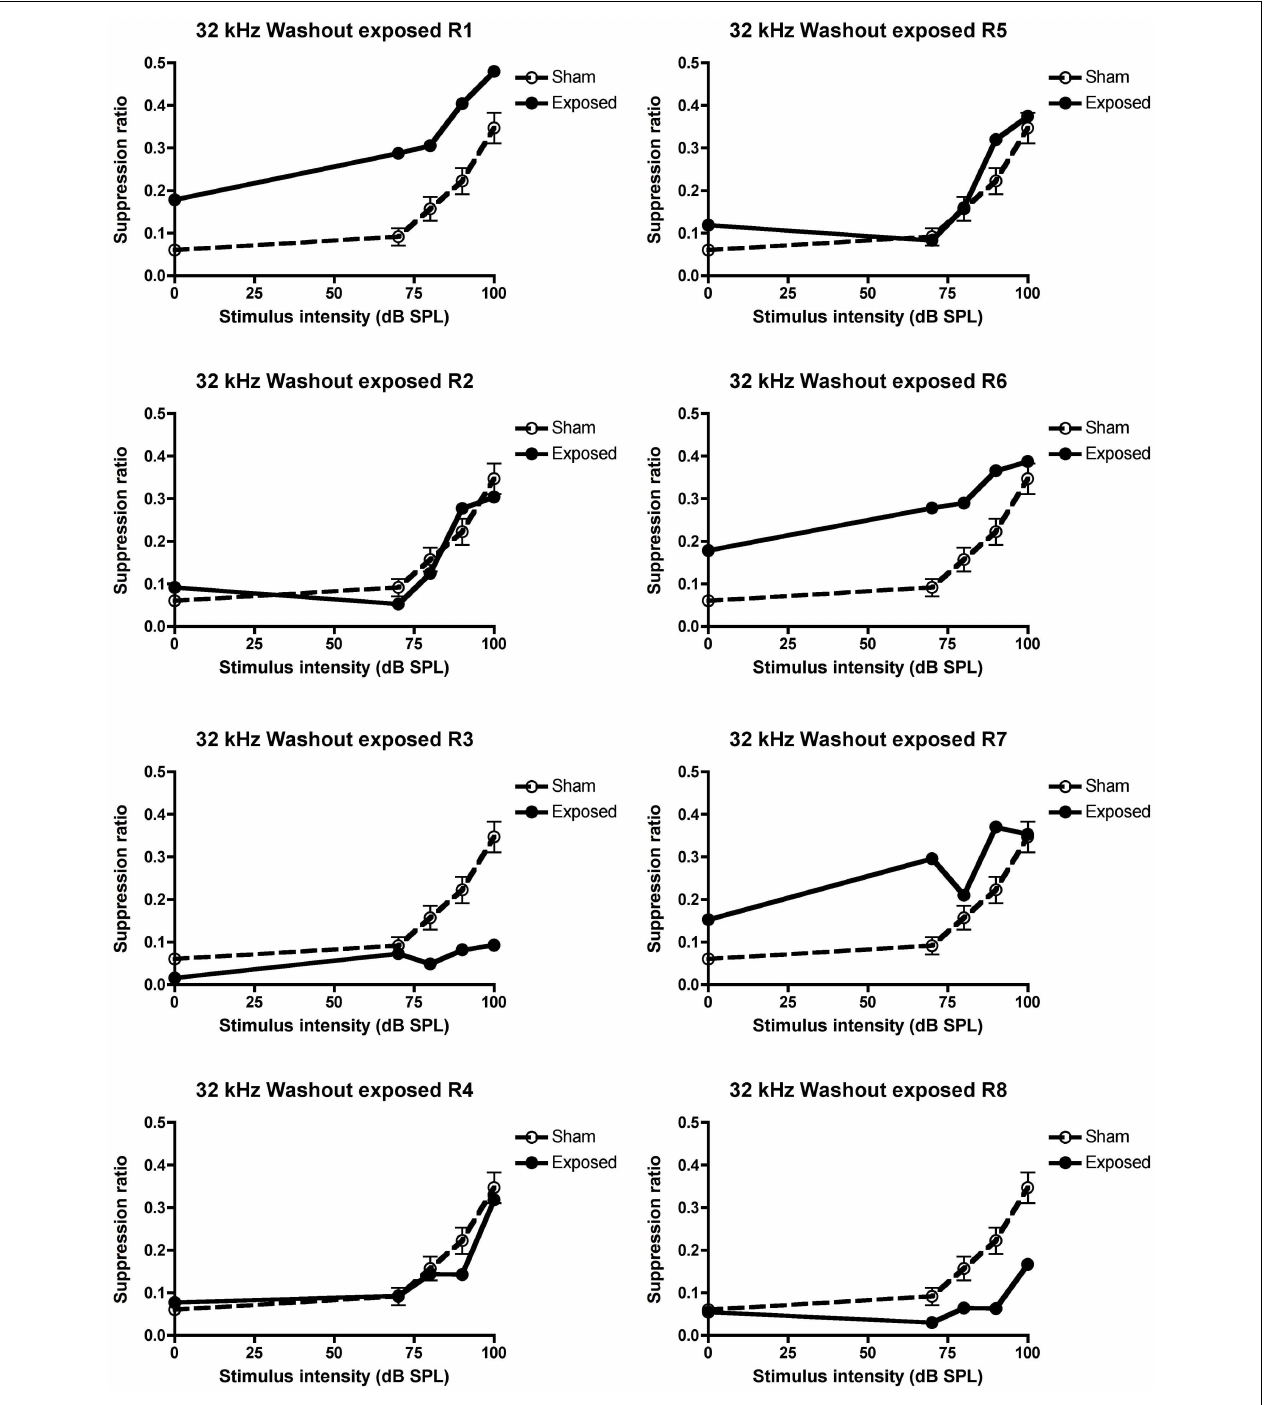
FIGURE 5 | Suppression ratios for the individual acoustic trauma-exposed animals plotted against the mean SRs of the sham control animals following the washout of the 5mg/kg s.c. memantine